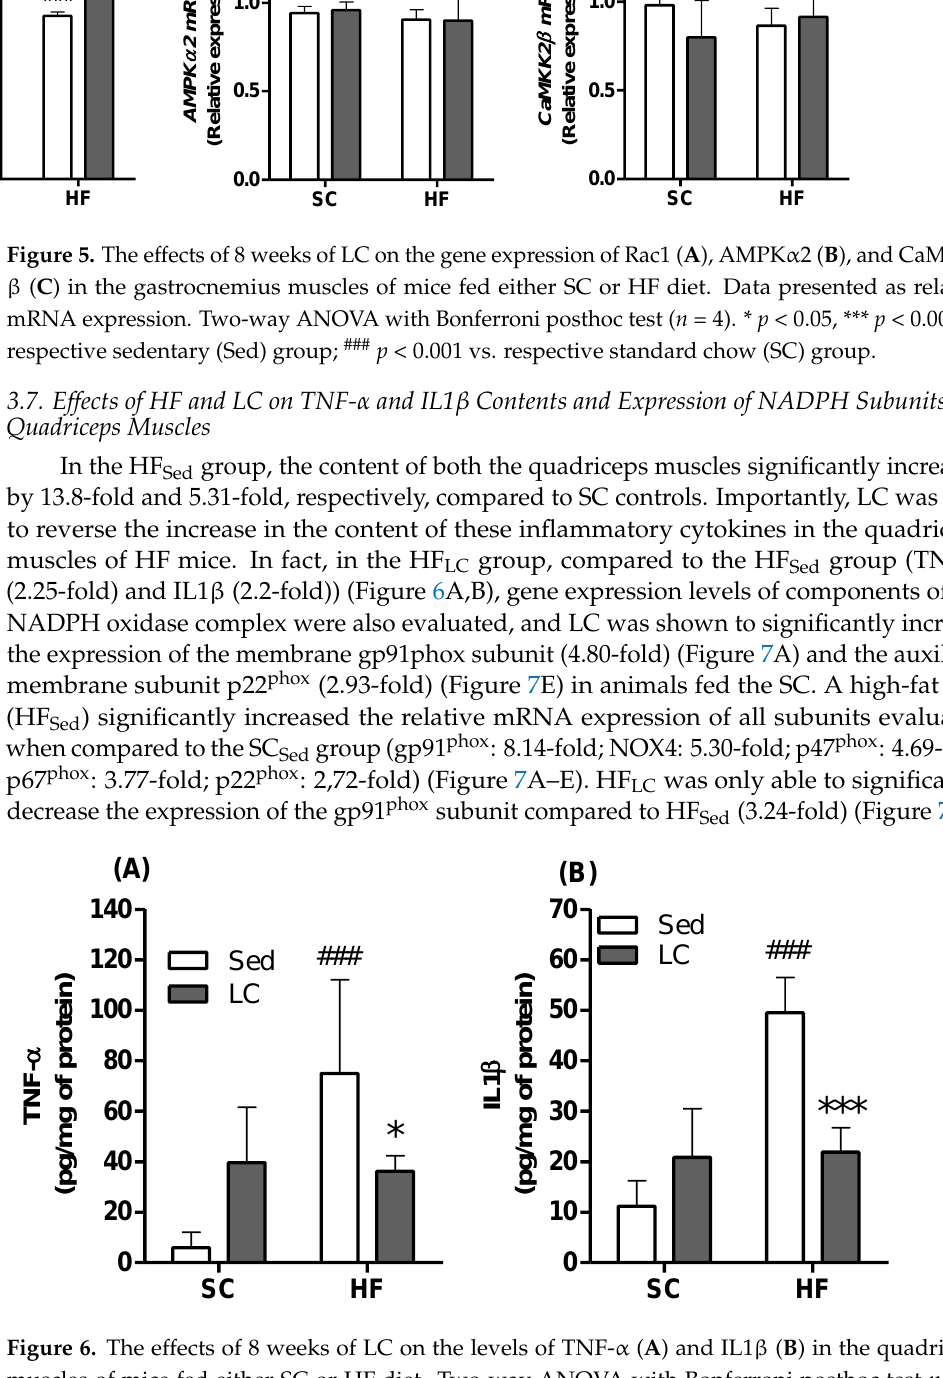
Figure 6. The effects of 8 weeks of LC on the levels of TNF- α ( A ) and IL1 β ( B ) in the quadriceps muscles of mice fed either SC or HF diet. Two-way ANOVA with Bonferroni posthoc test n = 5). * p < 0.05, *** p < 0.01 vs. respective sedentary (Sed) group; ### p < 0.001 vs. respective SC group.